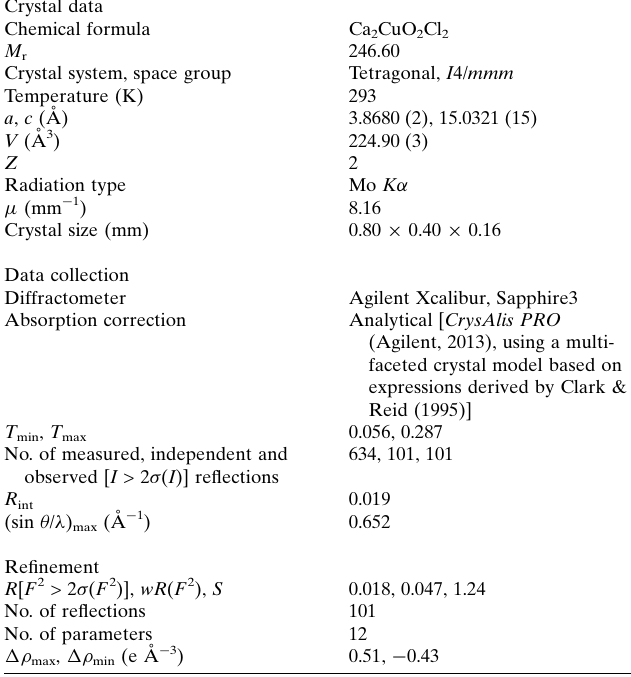
Table 2 Experimental details. Crystal data Chemical formula